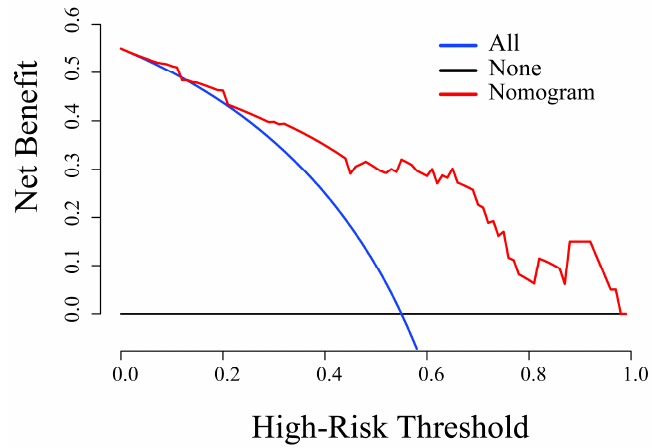
Figure 8. DCA for the radiomics nomogram in the validation cohort.